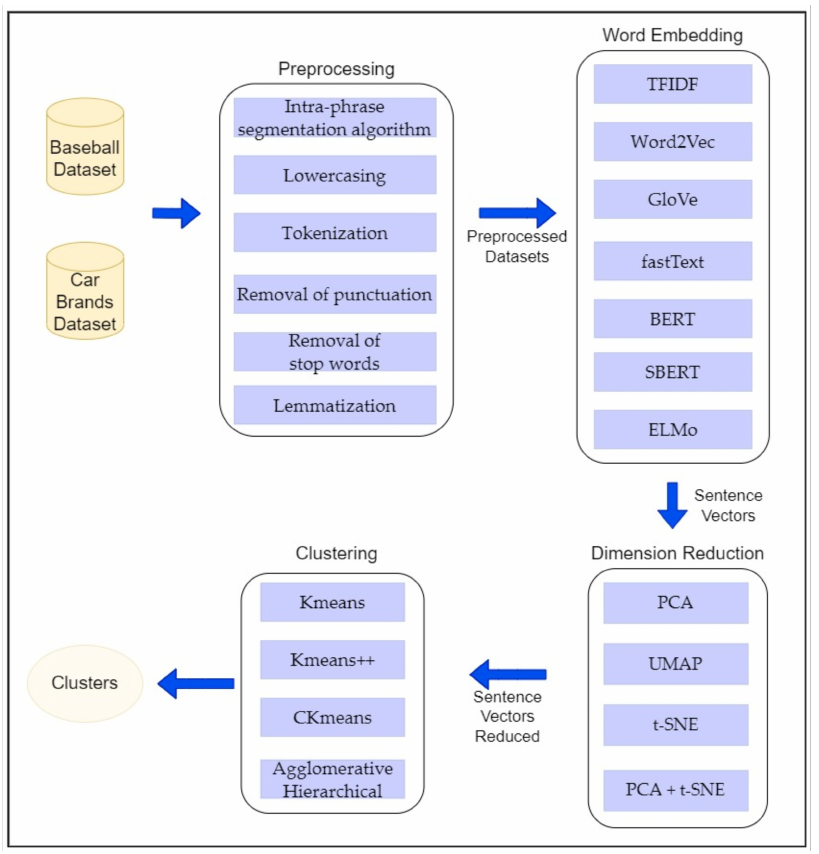
Figure 1. Methodology overview, adapted from [69]. Table 1. Quick visualization of the approach’s